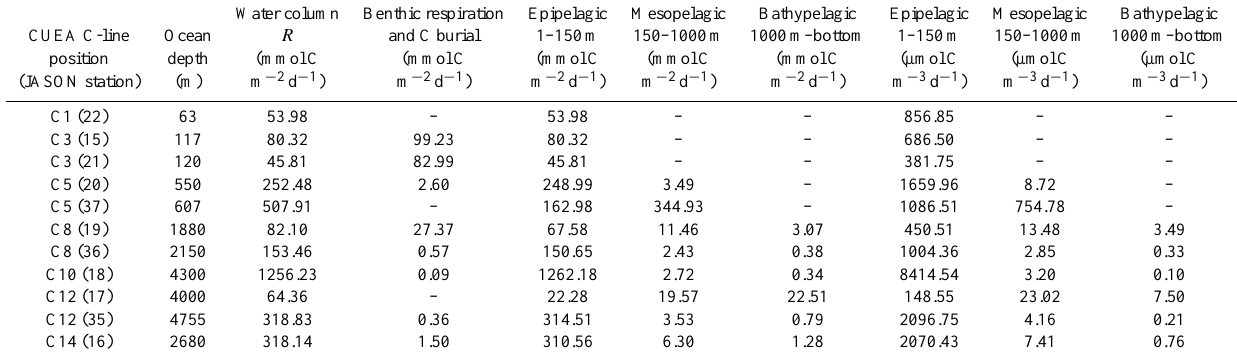
Table 5. Microplankton respiration in epipelagic, mesopelagic, and bathypelagic waters along the C-line across the Peruvian current up- welling system at 15 ◦ S. Calculations are based on the R models in Table 4. Shoreward of C5, the bottom limits the lower depth boundary. Note the 1000-fold shift in the rates expressed per area (columns 3–7) and per volume (columns